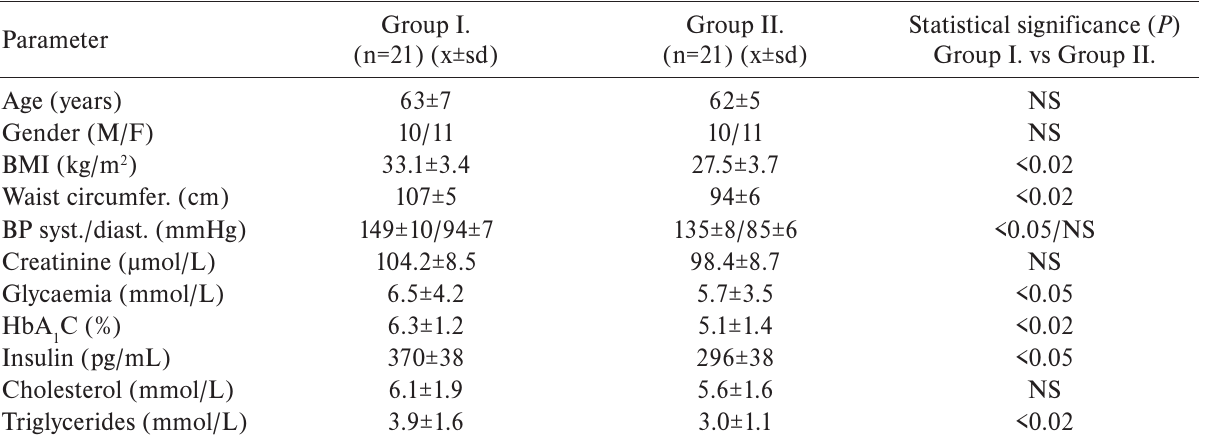
Table 1. Laboratory parameters in Group I and Group II before surgery.